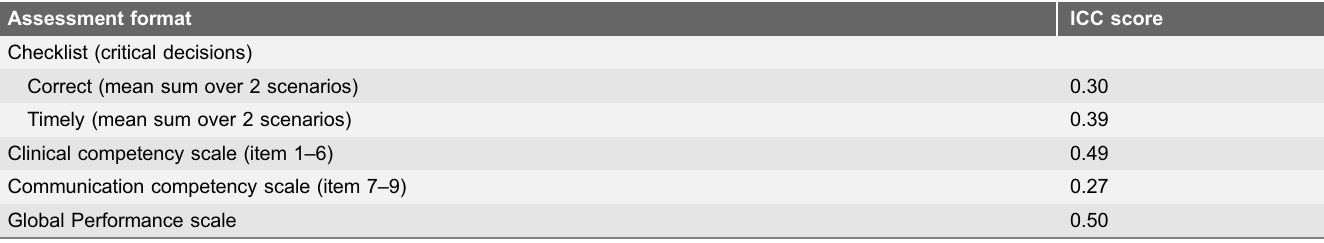
Table 3. IntraClass Correlation scores for the Checklist, Competency Scales and Global Performance